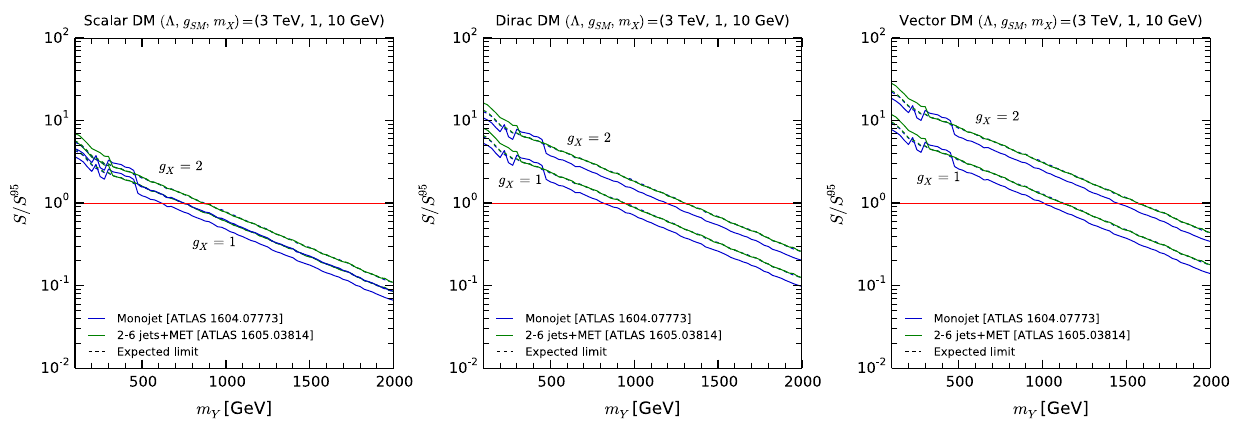
From left to right : scalar, Dirac and vector DM